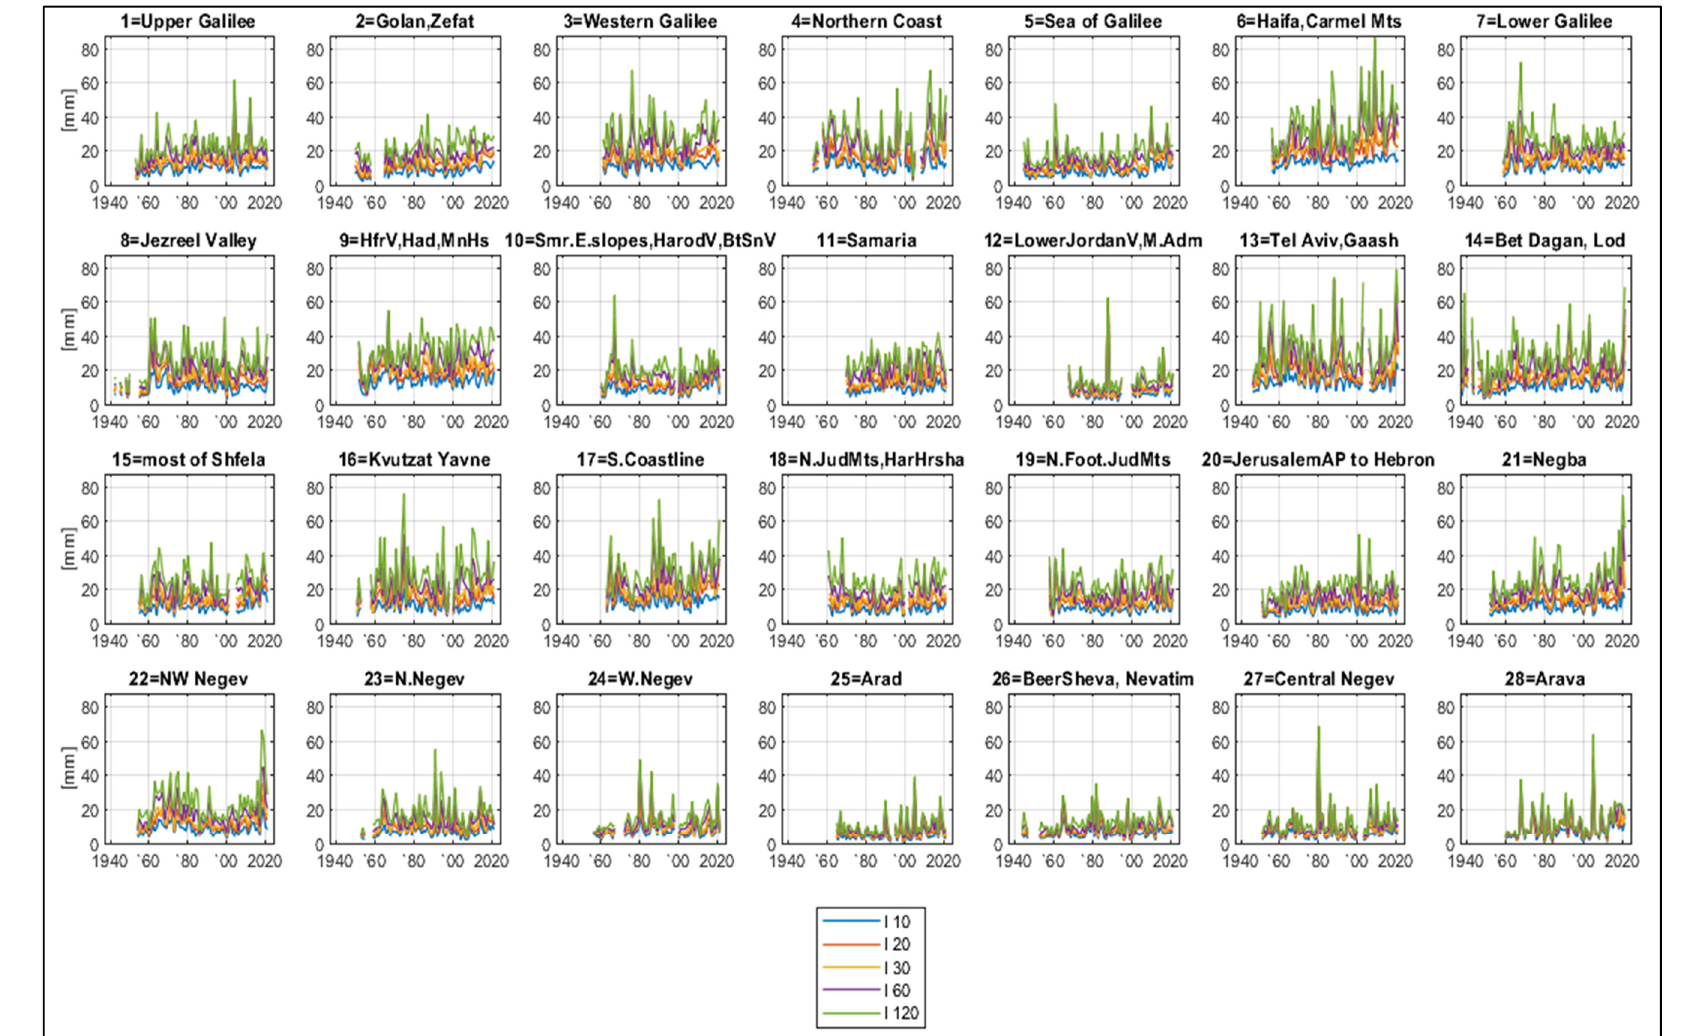
Figure 4. Annual maxima of 10-, 20-, 30-, 60-, and 120-min rainfall intensities (in units of rainfall amounts, mm per interval).